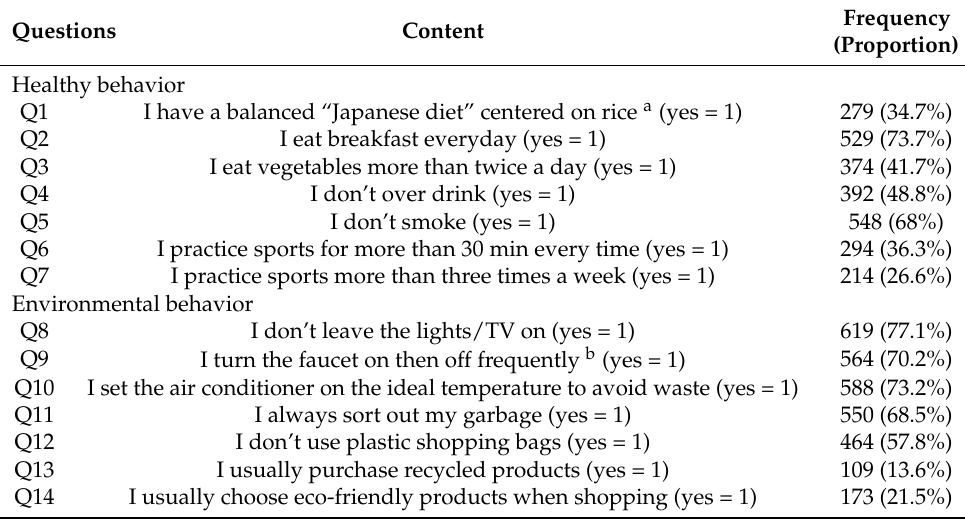
Table 3. Frequency and proportion of the healthy and environmental